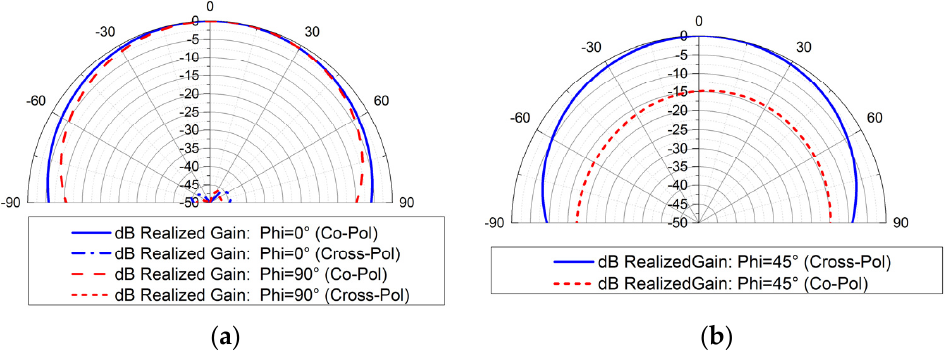
Figure 4. Simulated radiation patterns of the realized gain. ( a ) In the OFF state at Phi = 0° and at Phi = 90°; ( b ) in the ON state at Phi=45°.